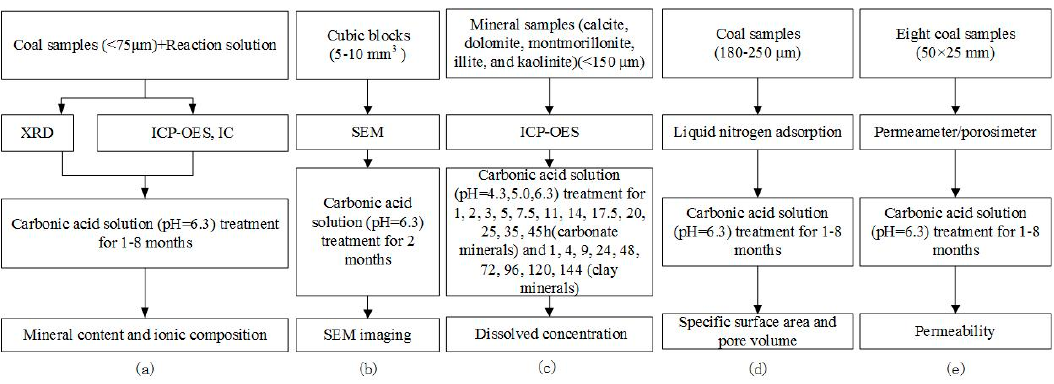
Figure 2. Scheme of acidification experiments and the techniques used in this study. ( a ) Measurement of mineral content and ionic composition of coal samples and reaction solution; ( b ) Coal samples were used to in-situ observation of dissolution structure; ( c ) Measurement of dissolved concentration performed on mineral samples (e.g., calcite, dolomite, montmorillonite, illite and kaolinite); ( d ) Measurement of specific surface area and pore volume performed on coal samples; ( e ) Eight coal samples used for permeability measurement.